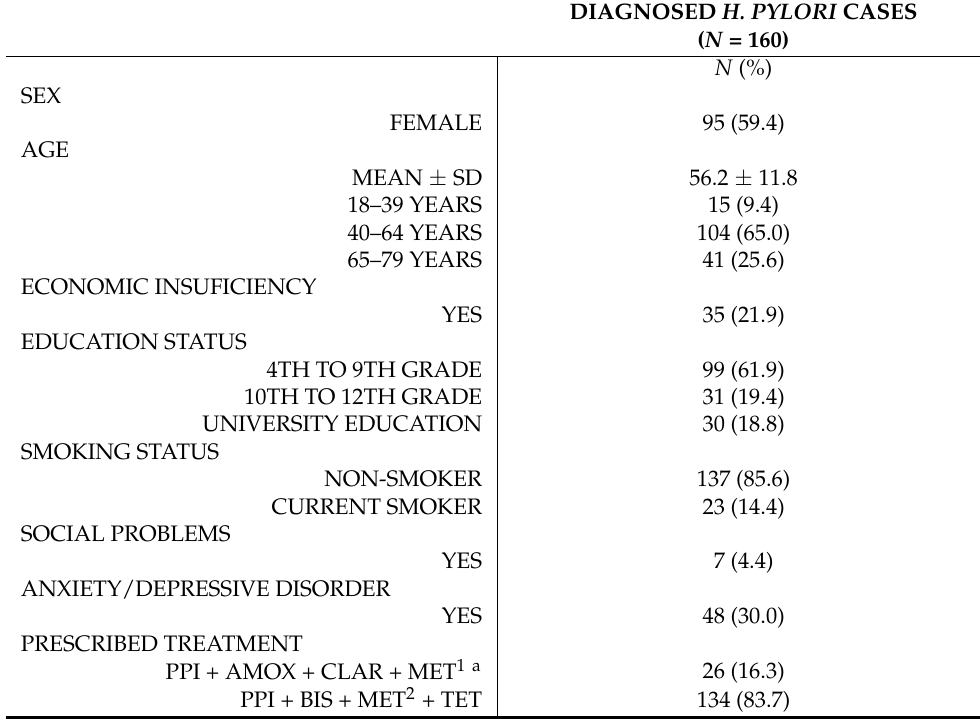
Table 1. Patients’